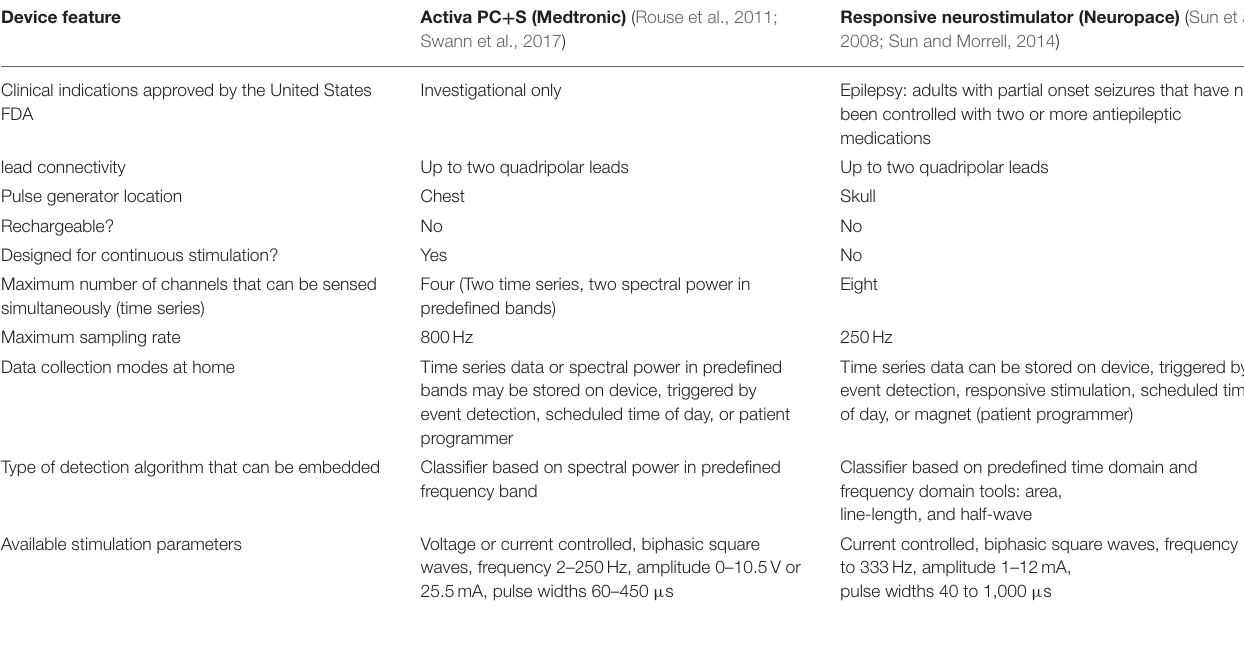
TABLE 1 | Comparison of two wireless bidirectional devices designed for brain